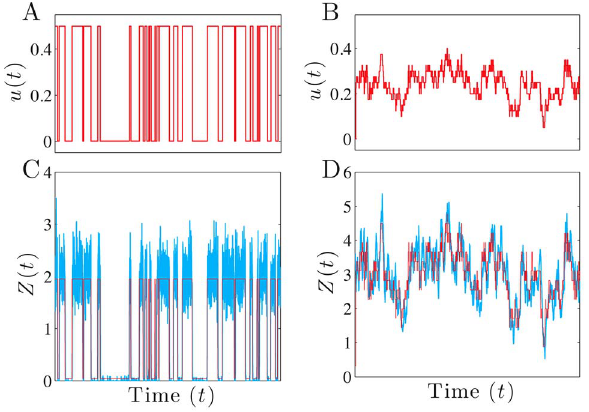
Figure 1. The dynamics of the protein output can result in a faithful representation of the current biological environment. We consider a 2-stage model of gene expression [22]. The extracellular environment or input, u ( t ) , gives the current rate of transcription and the signal of interest s ( t ) ~ u ( t ) . We model u ( t ) as either a 2-state Markov chain with equal switching rates between states (the states each have unconditional probability of 1 = 2 ) (A&C); or as proportional to a Poissonian birth-death process for a transcriptional activator (B&D; proportionality constant of 0.025). The transformed signals E ½ Z ( t ) D u ( t ) (cid:2) (in red, lower panels) are a perfect representation of u ( t ) , although protein levels Z ( t ) (in blue) are not. E ½ u ( t ) (cid:2) ~ 0 : 25 s { 1 , the lifetime d { 1 of u ( t ) equals 1 hr, and the translation rate v ~ 0 : 05s { 1 . Degradation rates of mRNA and protein are chosen to maximize the fidelity, Eq. 7. The units for Z ( t ) are chosen so that its variance equals one.